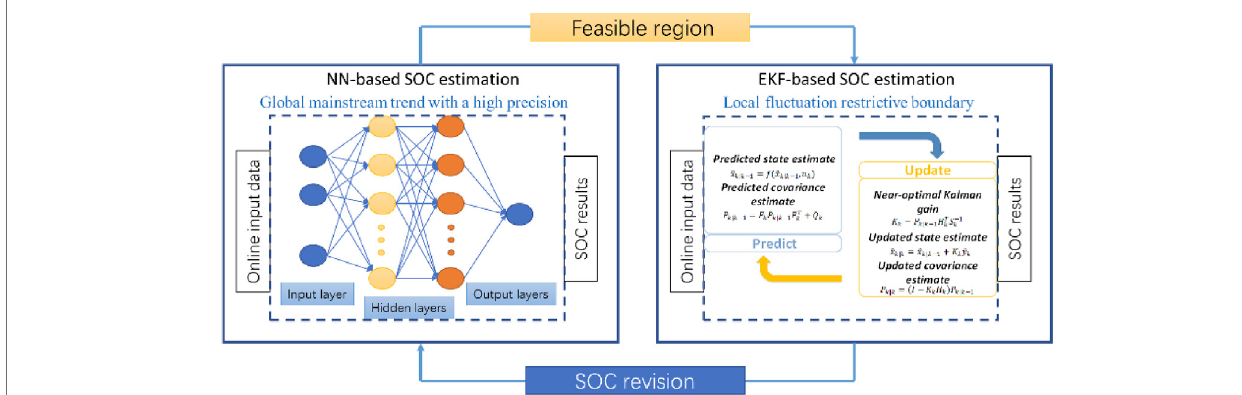
FIGURE 6 | The structure of the fusion estimation.